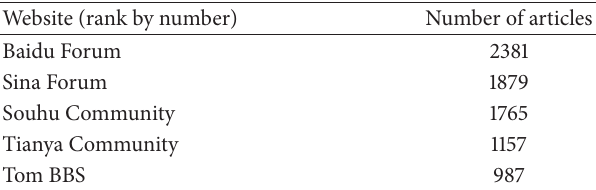
Table 1: Search source classification.